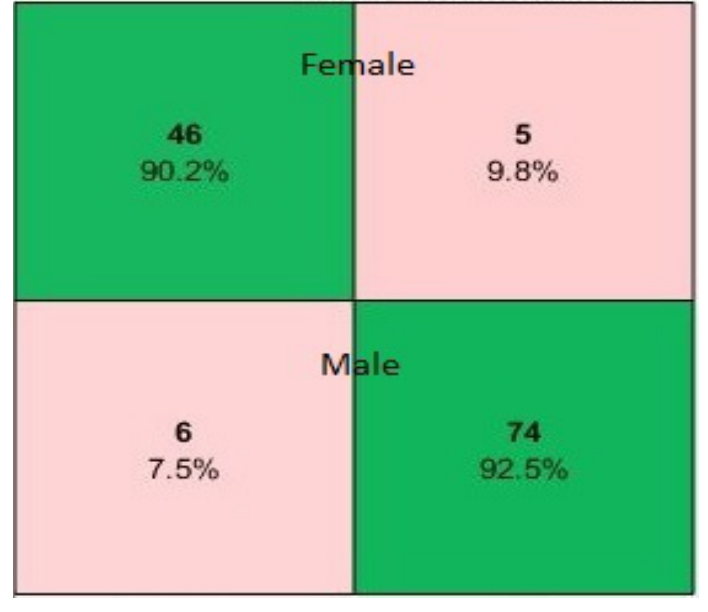
Fig. 5. Confusion